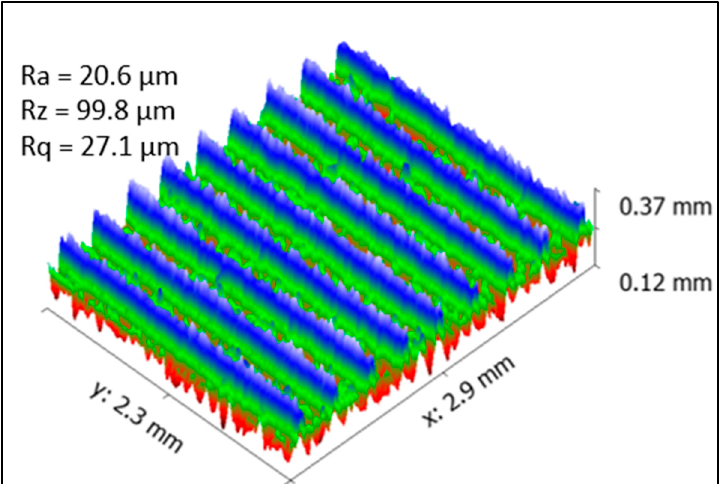
Figure 10. Design and fabricated flapping wing micro mechanism assembly with optimal FDM processing conditions.